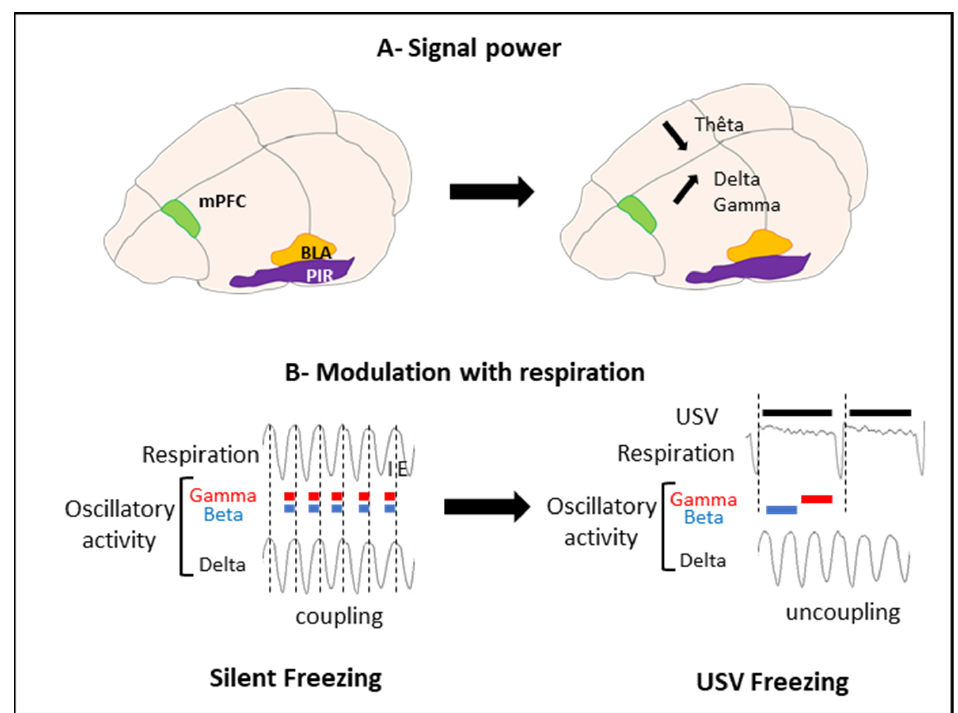
Figure 4. Effect of USV emission on oscillatory activity power and respiration. ( A ) Signal power. USV emission coincides with a decrease in theta power and an increase in delta and gamma power. ( B ) Modulation with respiration. Vertical dotted lines mark the transition between Inspiration (I) and Expiration (E). During silent freezing, the delta activity frequency covaries with the nasal respiratory frequency. In addition, power in the beta and gamma bands is modulated in phase with respiration, with a higher beta and gamma activity power during inspiration than expiration. During USV emission, a deep slow-down of respiratory frequency is observed, with the uncoupling between the delta frequency and respiratory frequency. Furthermore, a reorganization of beta and gamma activity power during the respiratory cycle occurs, with increased power during the first half of the expiration phase and increased gamma power during the second half of expiration (adapted from [108], Figure 10). mPFC: medial prefrontal cortex; BLA: basolateral amygdala; and PIR: piriform cortex.